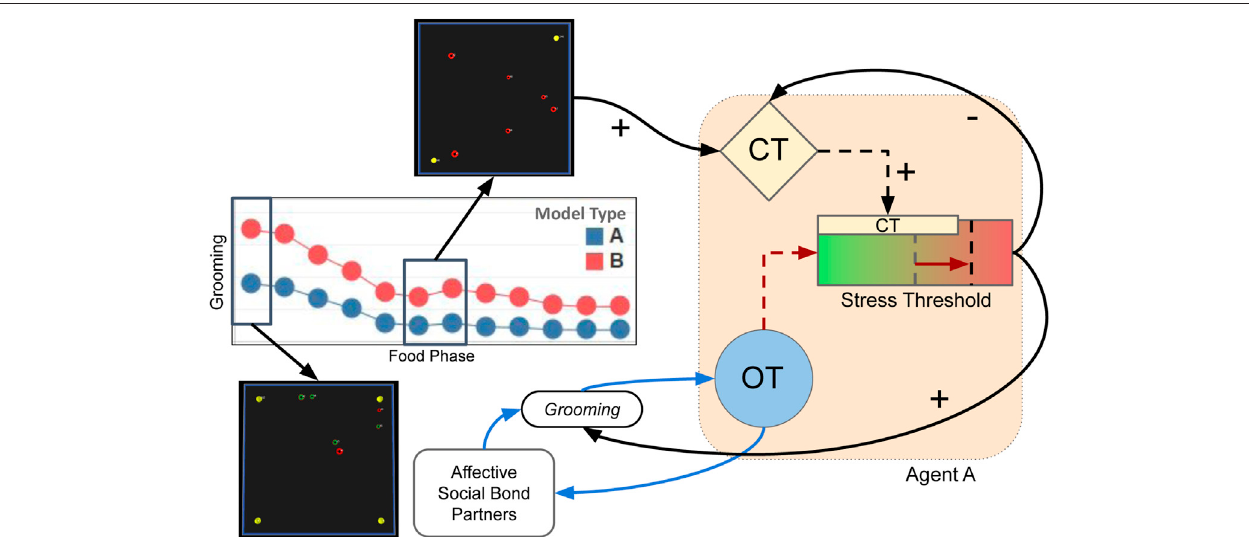
FIGURE 12 | Illustration for how early-stage socio-positive interaction in Type BV+ST, but not Type BV, models shaped long-term affective perception and the long-termef fi cacyof “ socialbuffering. ” Groominginearlystages(whenfoodwasmoreabundant)releasesOTinAgentA,whichreducestheperceptionofexternalstress ( Eq. 8 ) and therefore reducing CT release. In Type BV+ST models, OT adapts the internal Stress Tolerance, permitting higher amounts of CT to be tolerated before undergoing “ stress ” . In later food phases (in SEA and EXT conditions), when food becomes scarcer and external stress leads to increased CT release, CT levels were less likely to transgress the “ buffered ” Stress Tolerance value. This resulted in reductions in socio-negative interactions, and increased socio-positive interactions, between bond partners: which underpinned further OT release, improving valence of social support, and improved the long-term ef fi cacy of “ social buffering ” effects. + denotes increase of hormone or behaviour. - denotes a